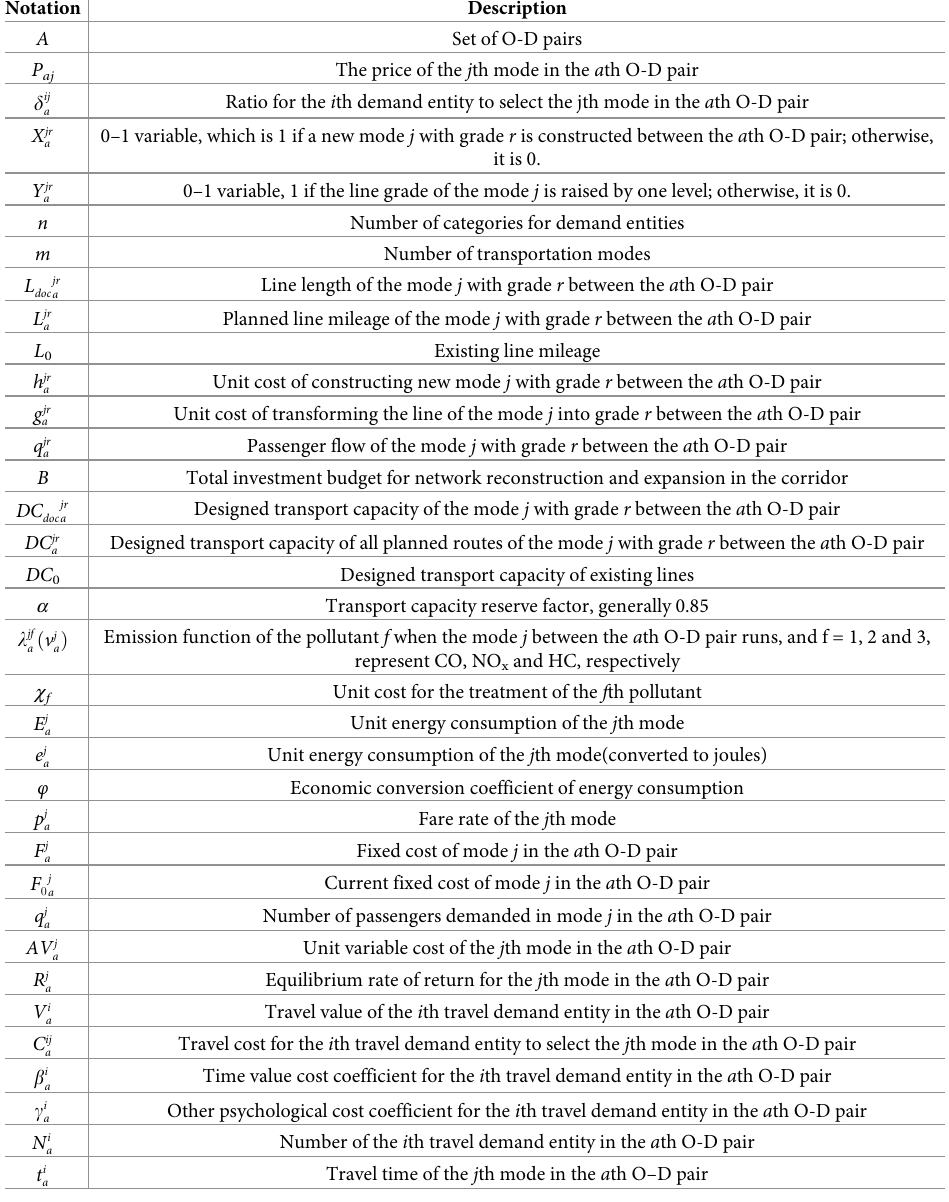
Table 1. Summary of